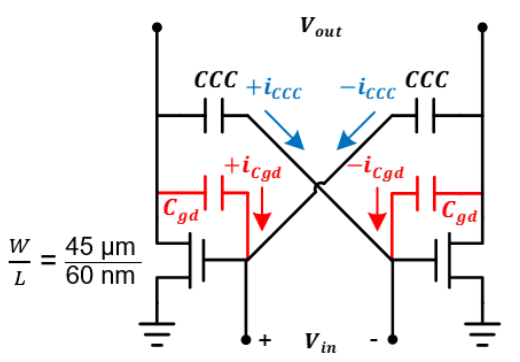
Figure 9. PA and DA circuits